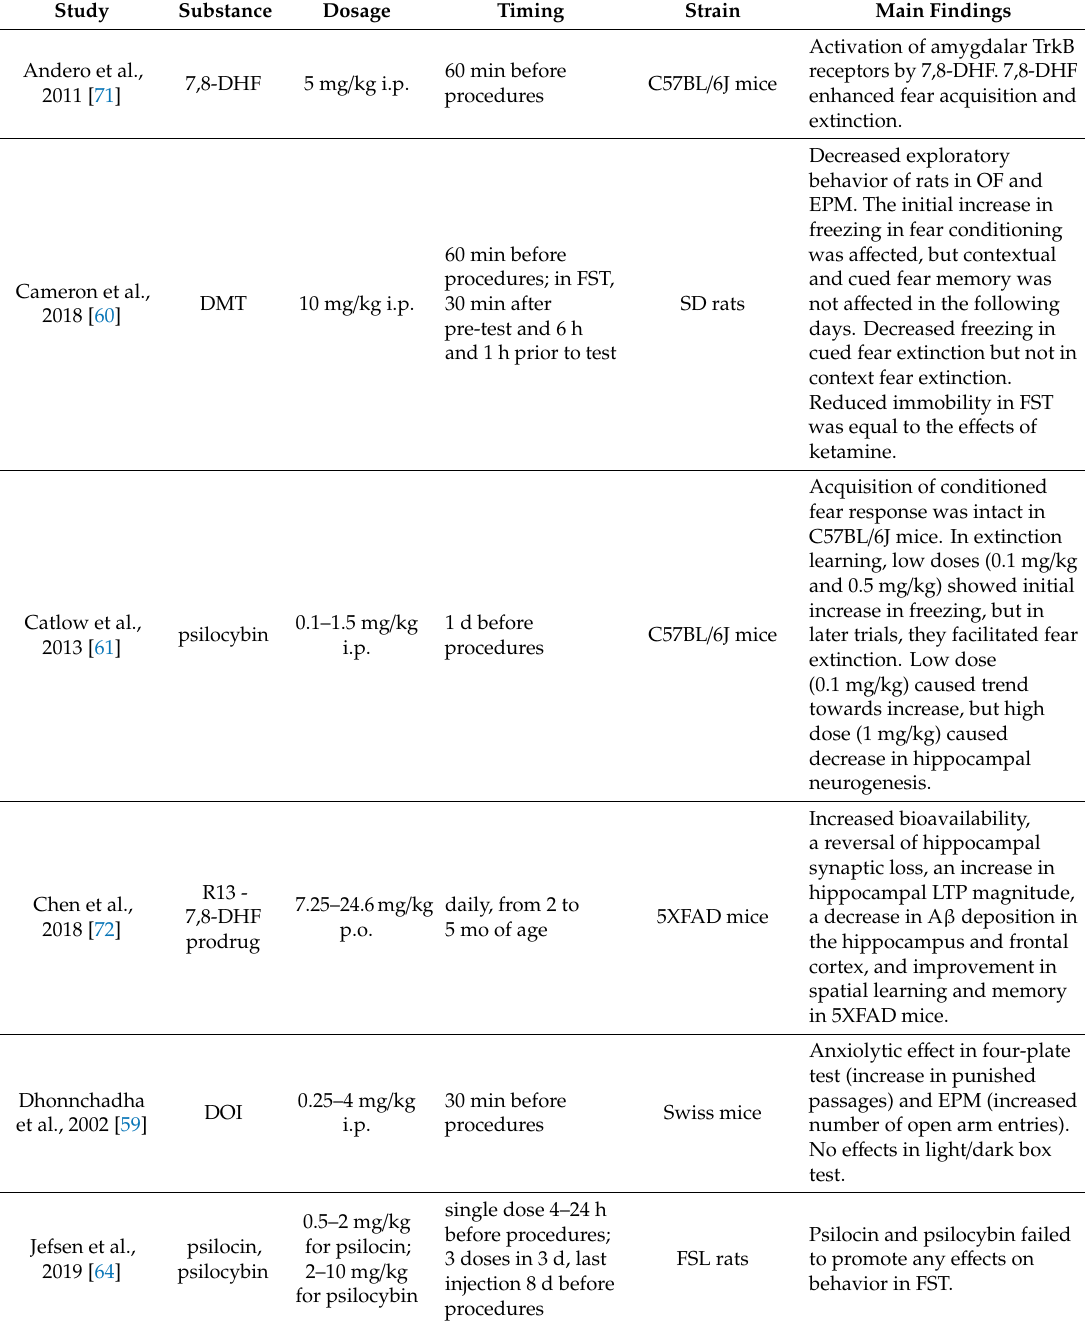
Table 1. Key animal studies on behavioral e ff ects of